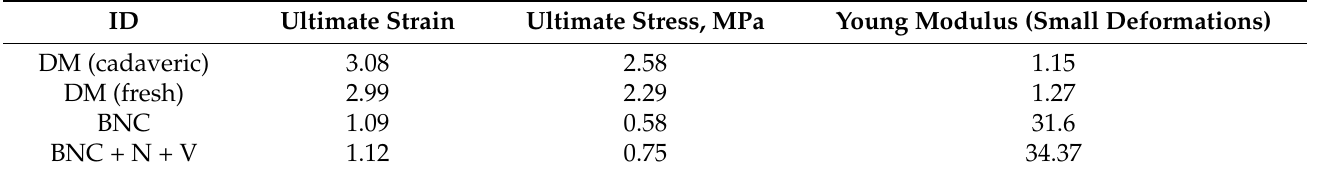
Table 3. Mean values of the material parameters (measurement error 0.6%).